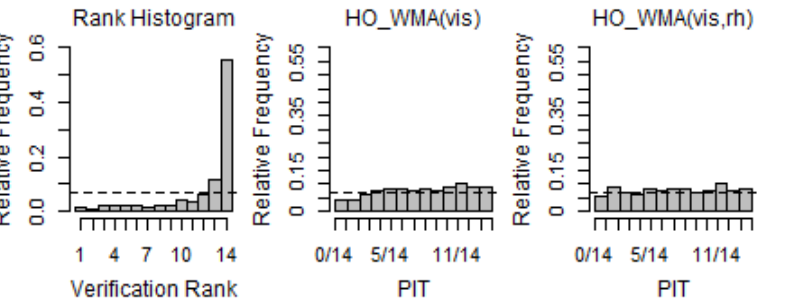
Figure 6. Verification rank histogram of raw ensemble forecasts and PIT histograms of WMA mod- els for Station 182 (2018–19 DJF).